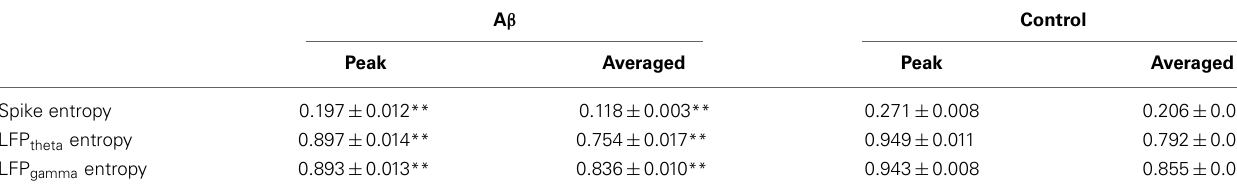
Table 1 | Entropy of neural activity during working memory task in the A β and control groups.